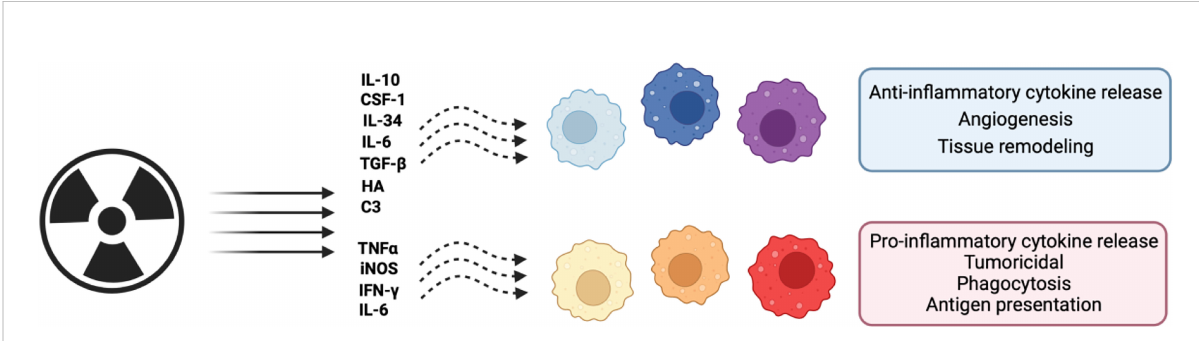
FIGURE 2 Schematic representation of the effects of radiation on macrophage polarization. Macrophages can adopt both pro- and anti-tumoral phenotypes across a spectrum of possible polarization states. Shown are the effects of radiation on these phenotypes and effector molecules. Figure created in Biorender. Agreement number: